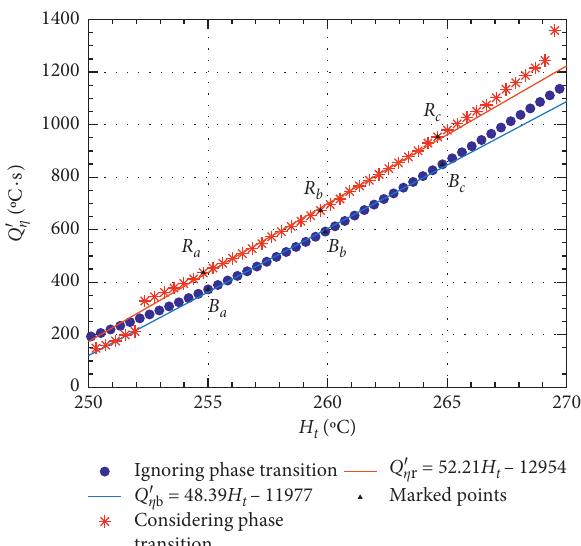
Figure 9: The relationship between the optimal heating factor Q ′ min